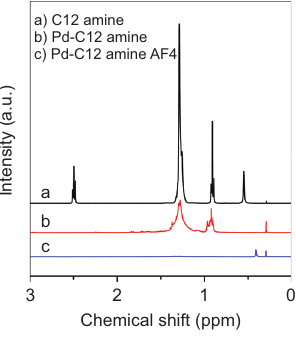
Figure 3 H 1 NMR spectra of dodecyl amine dissolved in d6-ben- zene, of the initial solution, and of the solution collected after the AF4 procedure.